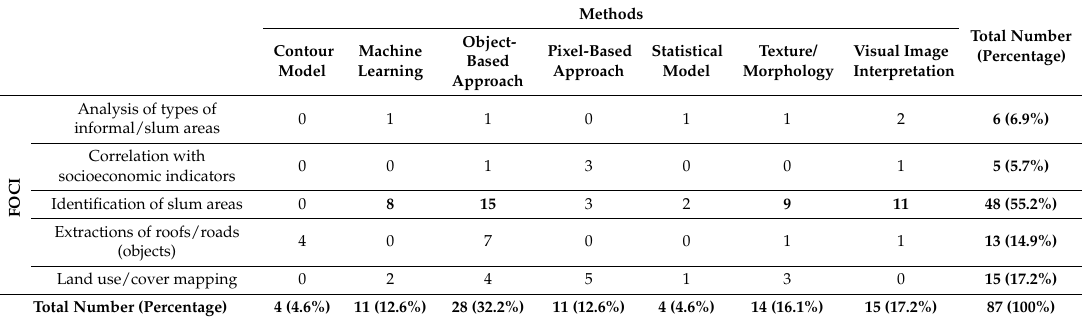
Table 7. Frequency of methods versus main focus for slum mapping using VHR